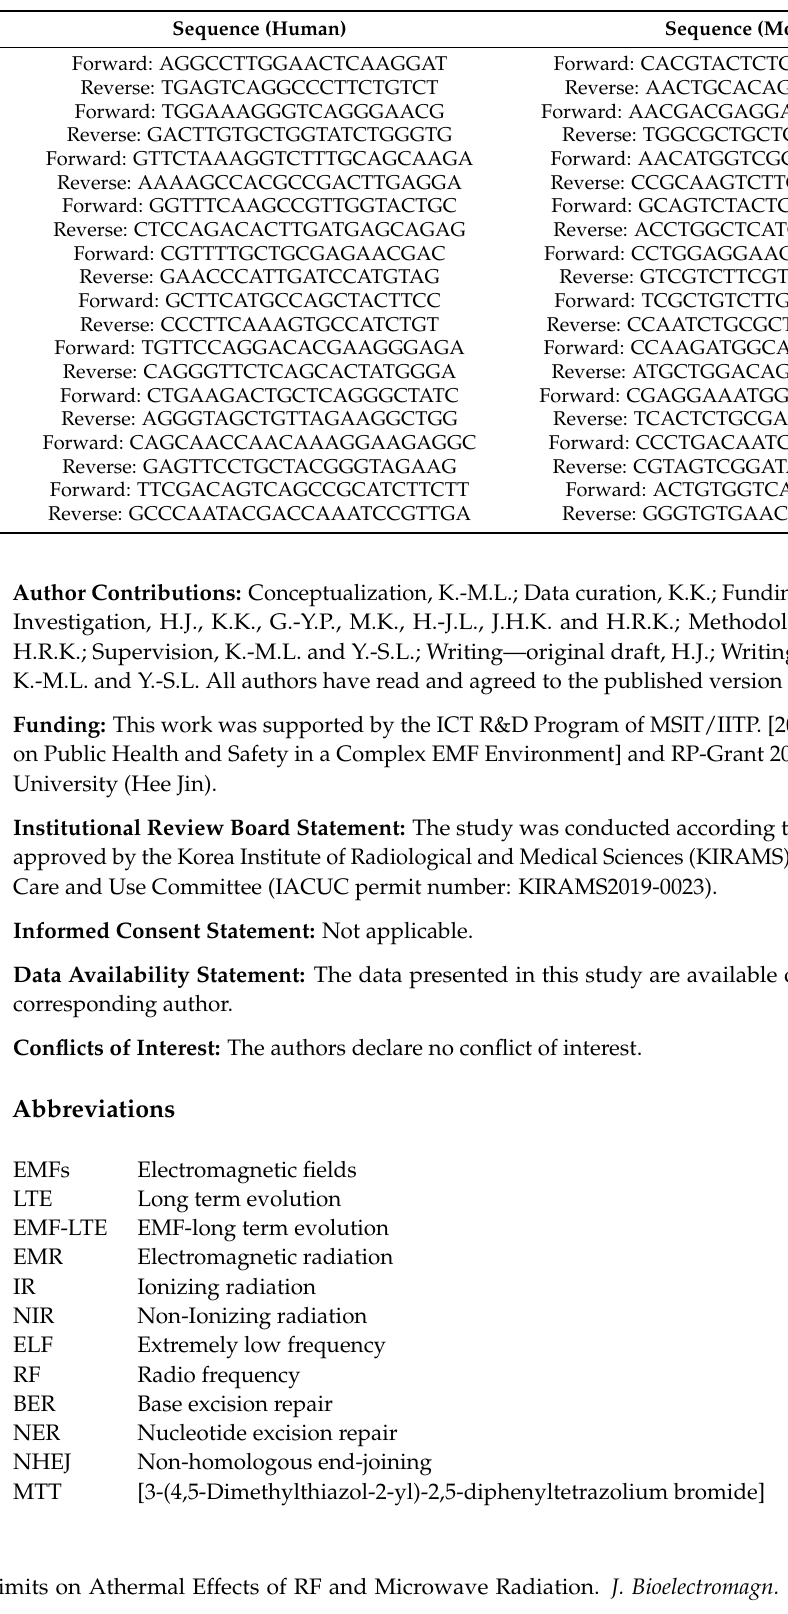
Table 1. Gene sequences used in quantitative real-time polymerase chain reaction (qRT-PCR)